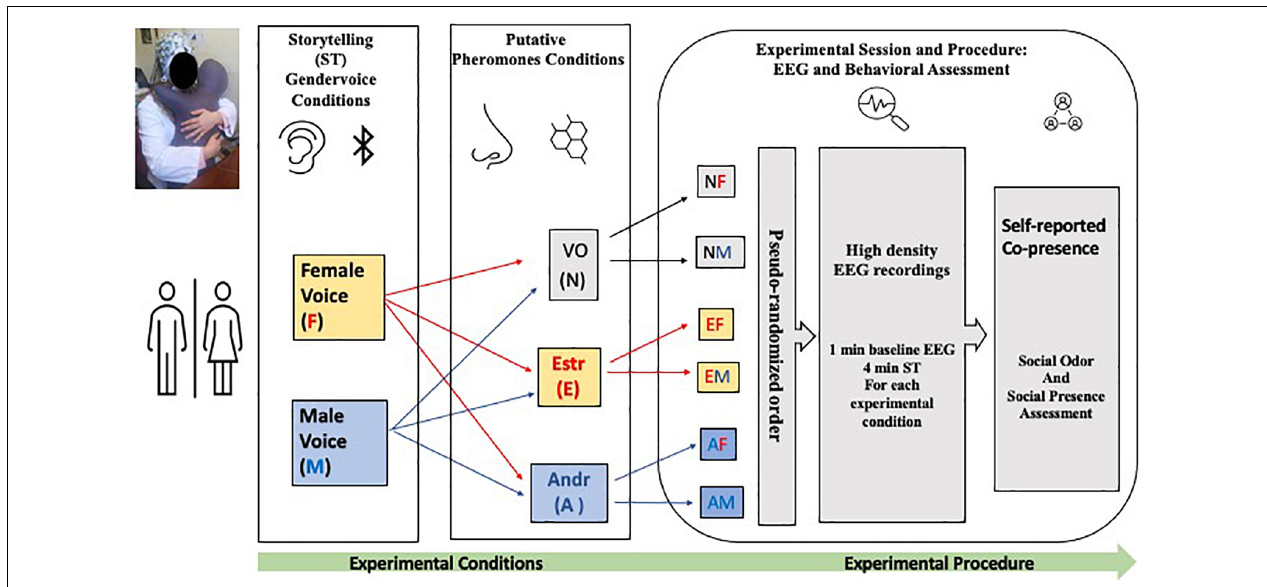
FIGURE 1 | Schematic representation of the experimental conditions and electrophysiological and behavioral assessment. The position of the Hugvie was pseudo randomized for each experimental condition. The duration of each story telling was of 4 min preceded by 1 min of electroencephalography (EEG) baseline recording.